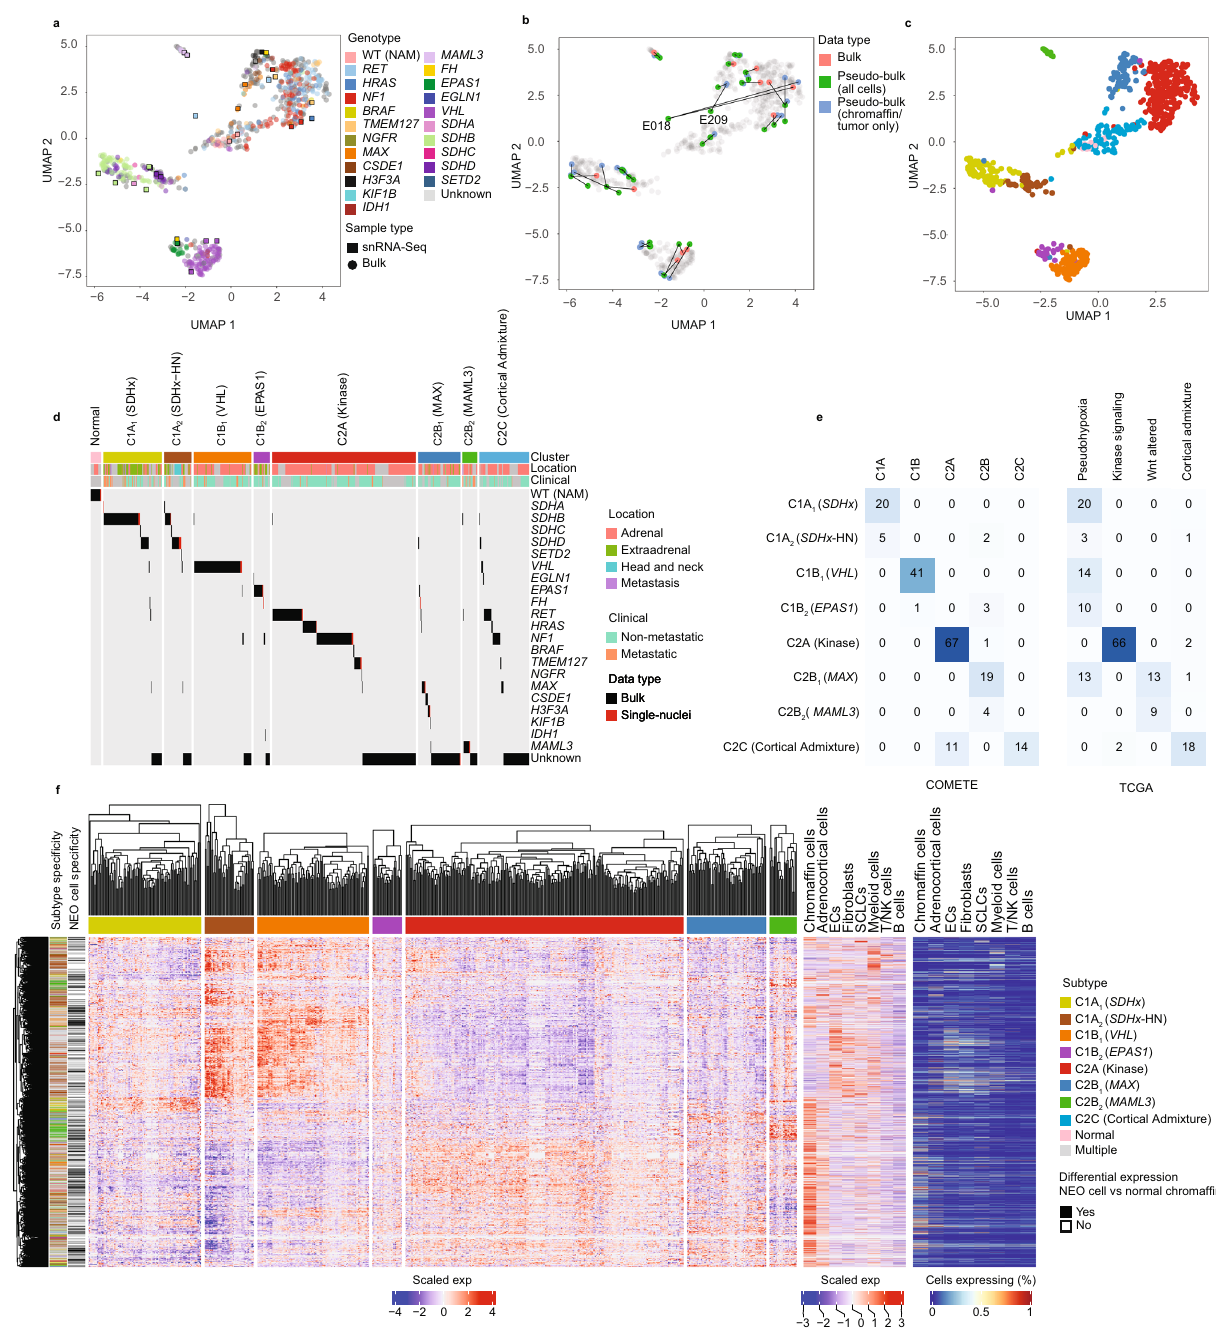
Fig. 2 | PCPG subtyping by consensus clustering of bulk-tissue and pseudo- bulked snRNA-seq gene-expression data. a UMAP projection of all bulk-tissue and snRNA-seq pseudo-bulked samples. Each dot represents an individual sample, colored by genotype (nBulk=735, n-snRNA=32) (WT (NAM): Wild-type normal adrenal medulla). b UMAP highlighting the relationships between paired bulk- tissue and pseudo-bulksnRNA-seq (NEO only and allcells).14/32samplesanalyzed withsnRNA-seqhadbulk-tissuegene-expressiondataavailable.Colorsindicatethe datatypeanddatapointsfromthesamesamplearelinkedbylines.(nBulk=735,n- snRNA=32) c UMAP illustrating tumor subtypes identi fi ed with consensus clus- tering, colored according to subtype as per panel d (nBulk=735, n-snRNA=32). d